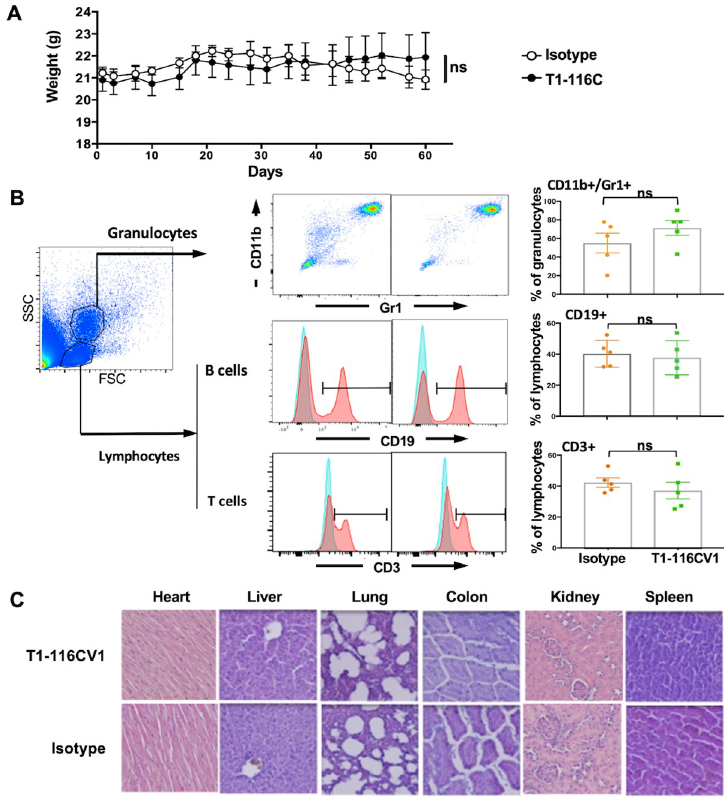
Fig 5. T1-116C exhibits no toxicity in human HLA-A2 transgenic HHD mice. Female HHD mice (6–8 weeks old) were injected intraperitoneally with T1-116CV1 (n = 5) or a control mAb (n = 5) at 20mg/kg, twice per week, for 8 weeks. Mice were monitored for signs of adverse effects throughout the course of treatment. ( A ) Monitoring of body weights (mean ± SEM). Mouse body weights were measured twice weekly. ( B ) Effect of antibody treatment on blood cell subsets. Antibodies against CD11b and Gr1 were used to identify the granulocytes, while antibodies against CD19 and CD3 were used to identify B and T lymphocytes respectively. The flow cytometry plots are representative of the results observed in each treatment group. No significant difference in the percentages of cells was observed between the T1-116CV1 and the control group. The bar graphs represent the mean ± SEM (n = 5). ( C ) Hematoxylin and eosin staining of organs showed no histological signs of toxicity. Representative images at 10X magnification are